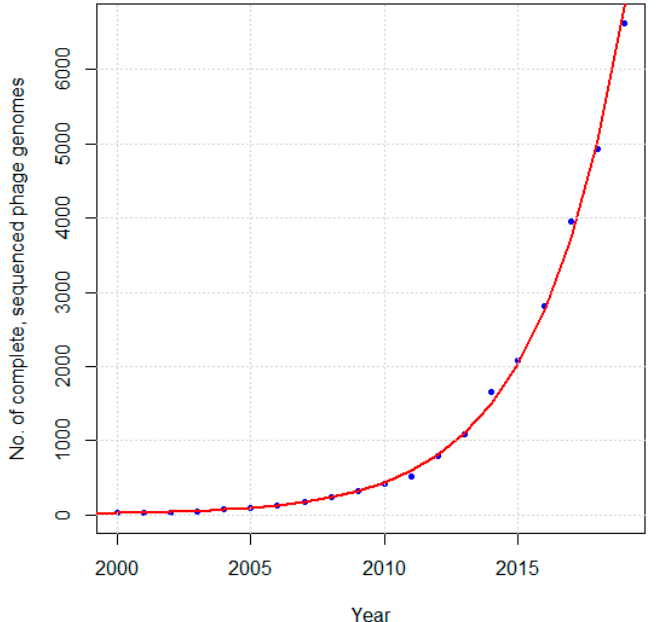
Figure 1. Cumulative number of unique, complete phage genome sequences in NCBI GenBank as of January 1 of each year since 2000. The red curve represents an exponential curve fit to the data (R 2 = 0.989, p -value = 0).